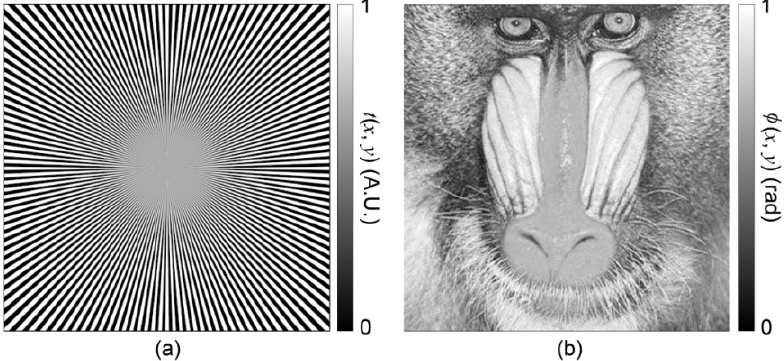
Figure 4. The simulated sample, where ( a ) is the amplitude, and ( b ) is the phase. NA ) is set to be 0.7 (the In simulations, the number aperture of the objective lens ( obj ° NA ) is set to be 0.56. For incident angle of 34 ). The illumination number aperture ( , max ill clarity, the magnification factor is set to be 1. The illumination wavelength λ is 525 nm. The sampling interval is 4 λ . The size of the simulated image is 500 × 500 pixels. Annular oblique illumination is simulated by using 120 plane waves with the wave